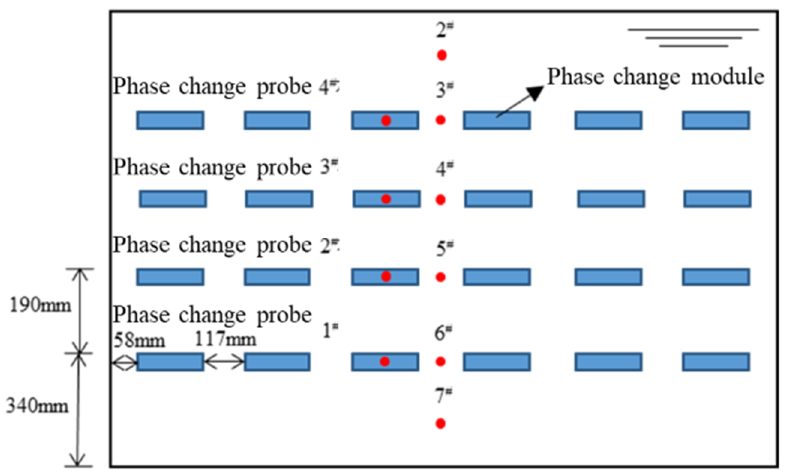
Figure 4. Layout diagram of the temperature-measuring points in phase change heat storage reser-